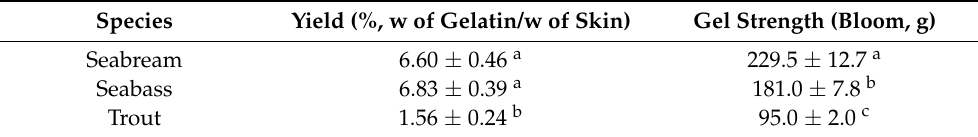
Table 1. Yield and gel strength of gelatin extracted from seabream, seabass and rainbow trout skin. Values expressed as average ± intervals of confidence for n = 2 (replicates of independent batches) and α = 0.05. Different superscript letters in each row mean statistically significant differences between fish species ( p <